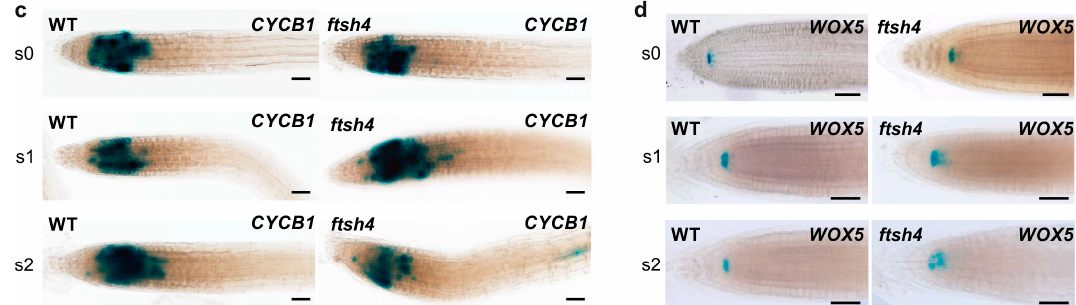
Figure 2. Impairment of proliferative activity and quiescence center (QC) cell identity in ftsh4-1 mutant roots. ( a ) The length of the root and root apical meristem (RAM), the number of the RAM cells and the size of the cells in the elongation zone of wild-type (WT) and ftsh4-1 mutant plants grown under long day photoperiod (LD) conditions at 30 °C. Seeds were germinated and grown for three days at 22 °C, and then transferred to 30 °C (S0) to continue growing for three days (S1) and six days (S2). Results are expressed relative to the WT S0 sample (average values for WT plants from S0 are as follow: root length 2.6 mm, meristem size 164 μ m, meristematic cells number 14.4, cell length in elongation zone 127 μ m). WT and mutant plants are comparable at S0 and S1 time-point, but then root and RAM size, RAM cell number and elongation cells size decreases in the ftsh4-1 mutant S2 sample in comparison to the WT S2 sample. Two biological replicates of the experiment were performed. The root length, meristem length and meristematic cells number was measured in at least 10 plants of each genotypes; average size of cells in the elongation zone was estimated from randomly measured three cells per root. Mean values (±SE) are shown and significant differences between bars at p < 0.05 are denoted by asterisks; ( b ) comparison of S-phase progression (cell division) directly in the meristems of S0 (at the time of transfer), S1 and S2 RAM of wild-type and ftsh4-1 mutants grown at 30 °C. A decreased in the number of S-phase cells (green signal) was detected in the S1 ftsh4-1 mutant plants in comparison to WT plants. Scale bars: 40 μ m. The table shows the total number of cycling cells (i.e., in S-phase) and the mitotic index (percentage of cycling cells relative to the total number of SAM cells) in S0, S1 and S2 wild-type and ftsh4-1 mutant plants grown at 30 °C; ( c , d ) activity of the At CYCB1 ( c ) and At WOX5 ( d ) promoters visualized by the activity of the GUS reporter protein (blue). Transgenic plants were grown as described in ( a ) and expression levels were analyzed during the S0, S1 and S2 stages of development in the WT and ftsh4-1 mutants. ftsh4-1 mutants were characterized by comparable GUS activity for both promoters at S0 and S1 stages, only slightly weaker activity (not fully penetrant phenotype) in case of the At CYCB1 promoter ( c ) and much weaker and diffusible in case of the At WOX5 promoter ( d ) in the S2 stage. Scale bars: 40 μ m.